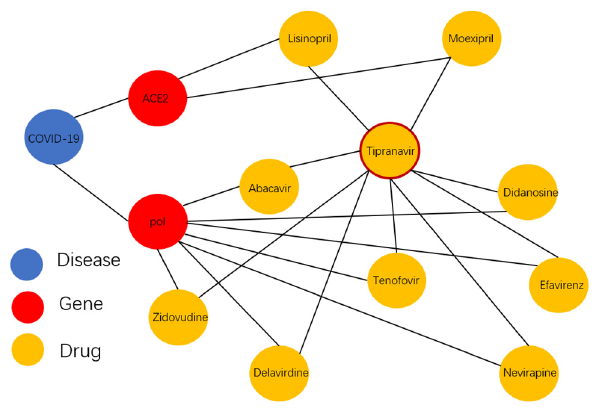
Figure 3. Path between Tipranavir and